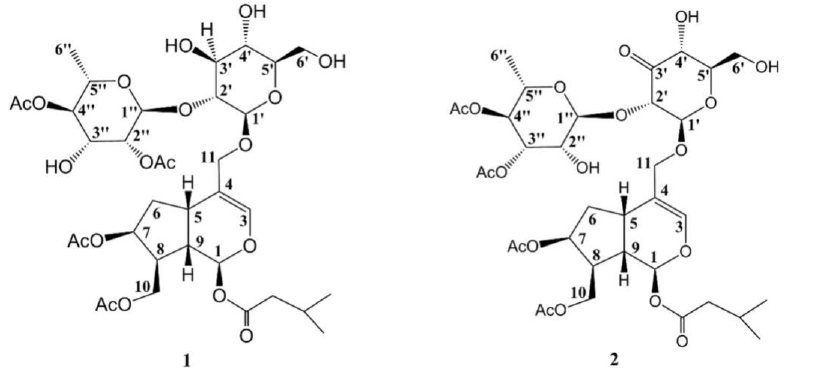
Figure 4 . New types of extracted compounds (Alipieva et al., 2017)